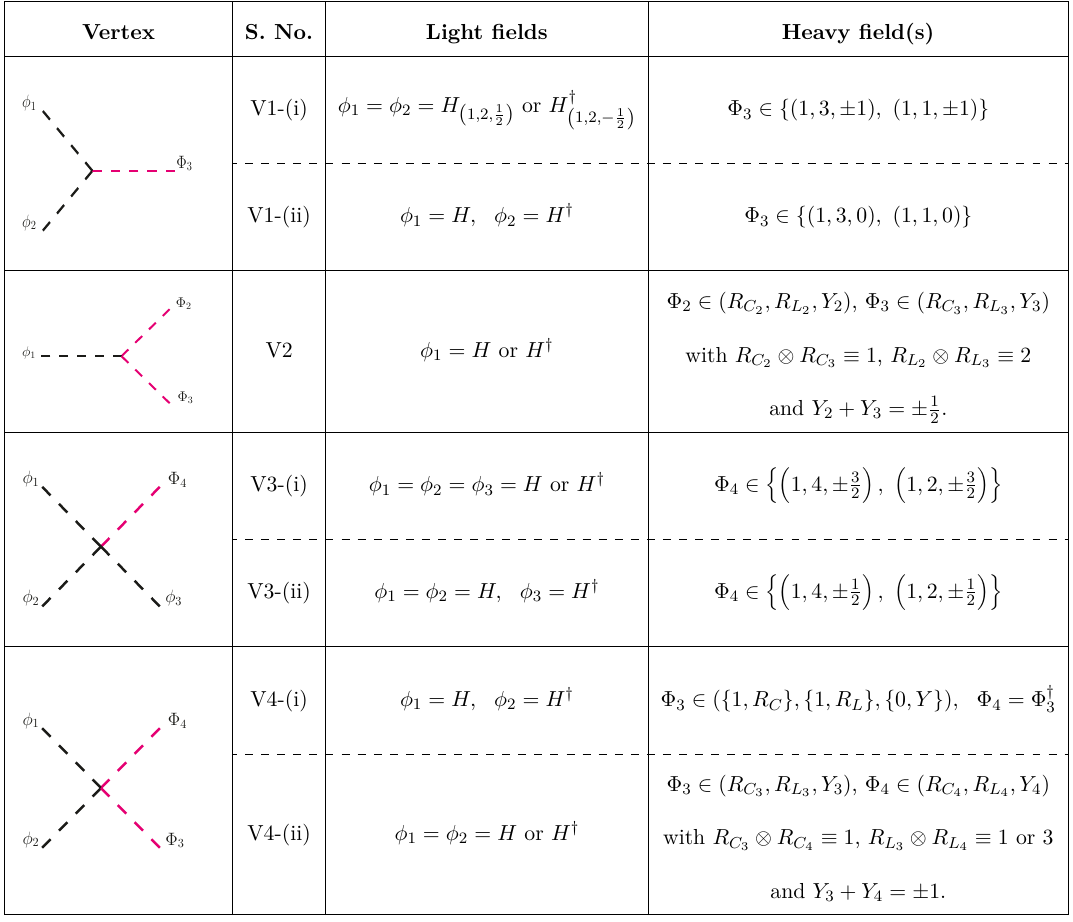
and R denote C L hypercharge Y